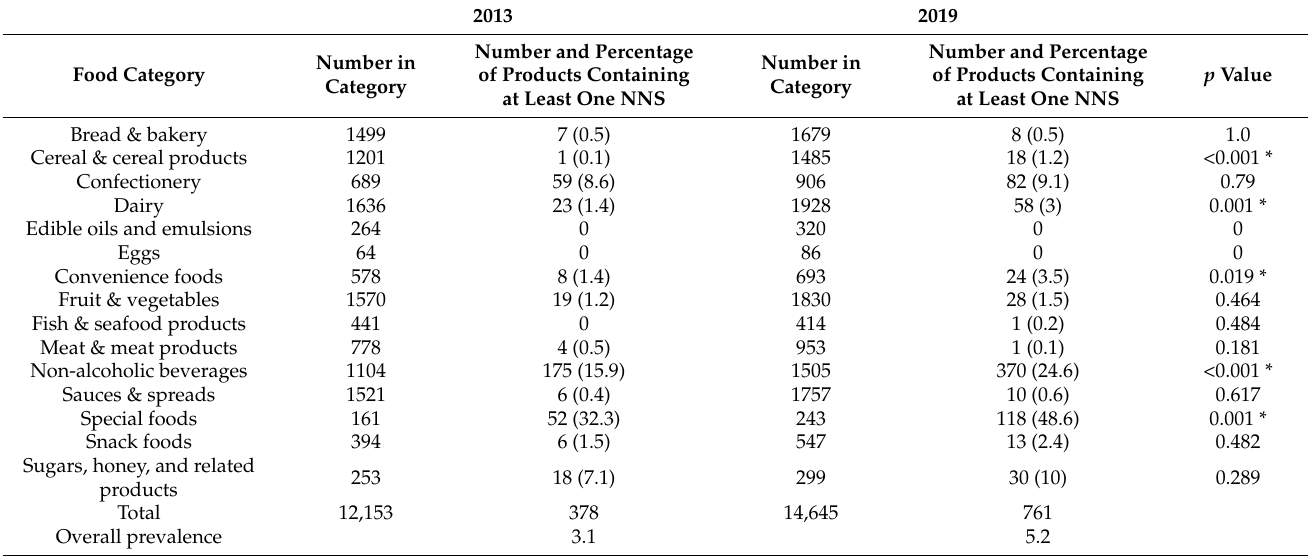
Table 2. Number and percentage of products containing at least one NNS by food category and overall, in 2013 and